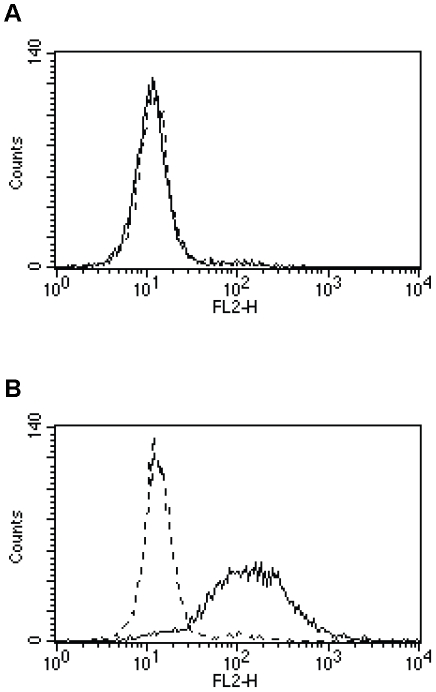
Surface expression of Her2/neu on EL4-Her2 cells.Surface expression of human Her2/neu on EL4 (A), and EL4-Her2 cells (B), analysed by flow cytometry using the anti-Her2/neu-PE antibody (solid line) or relevant isotype control (dashed line).